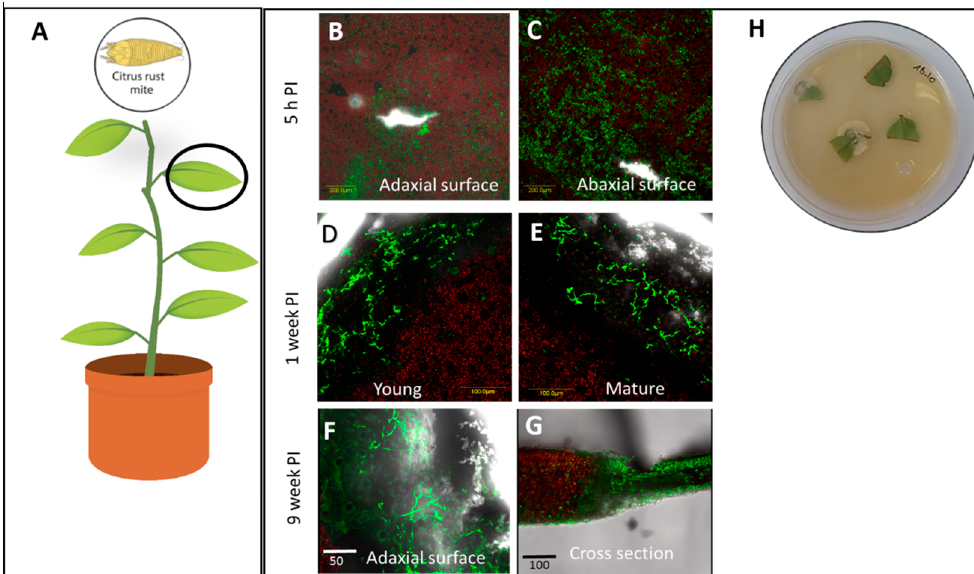
Figure 1. Observation of endophytic establishment of Metarhizium brunneum -7 (Mb7) in citrus leaves following leaf infiltration with 0.1 mL conidia suspension (10 7 conidia ML − 1 ) at three time points post inoculation. ( A ) Site of infiltration and examination of citrus seedlings. ( B – G ) Leaf colonization by Mb7 by confocal laser scanning microscopy (CLSM). ( H ) Recovery of endophytic Mb7 from leaf tissue fragments. PI, post inoculation. Green florescent, Mb7-green fluorescent protein (GFP); red fluorescent, plant tissue.